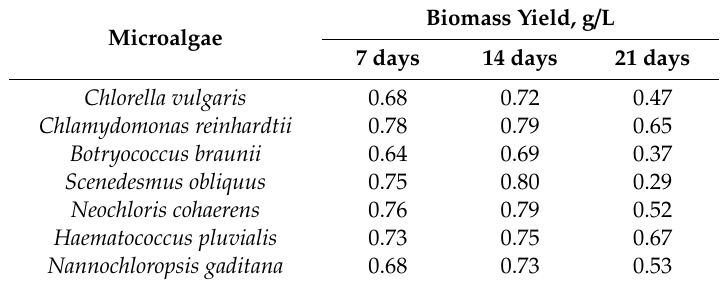
Table 2. The influence of cultivation time on the growth of various microalgae (table reconstructed using data from Qiu et al. [8]).